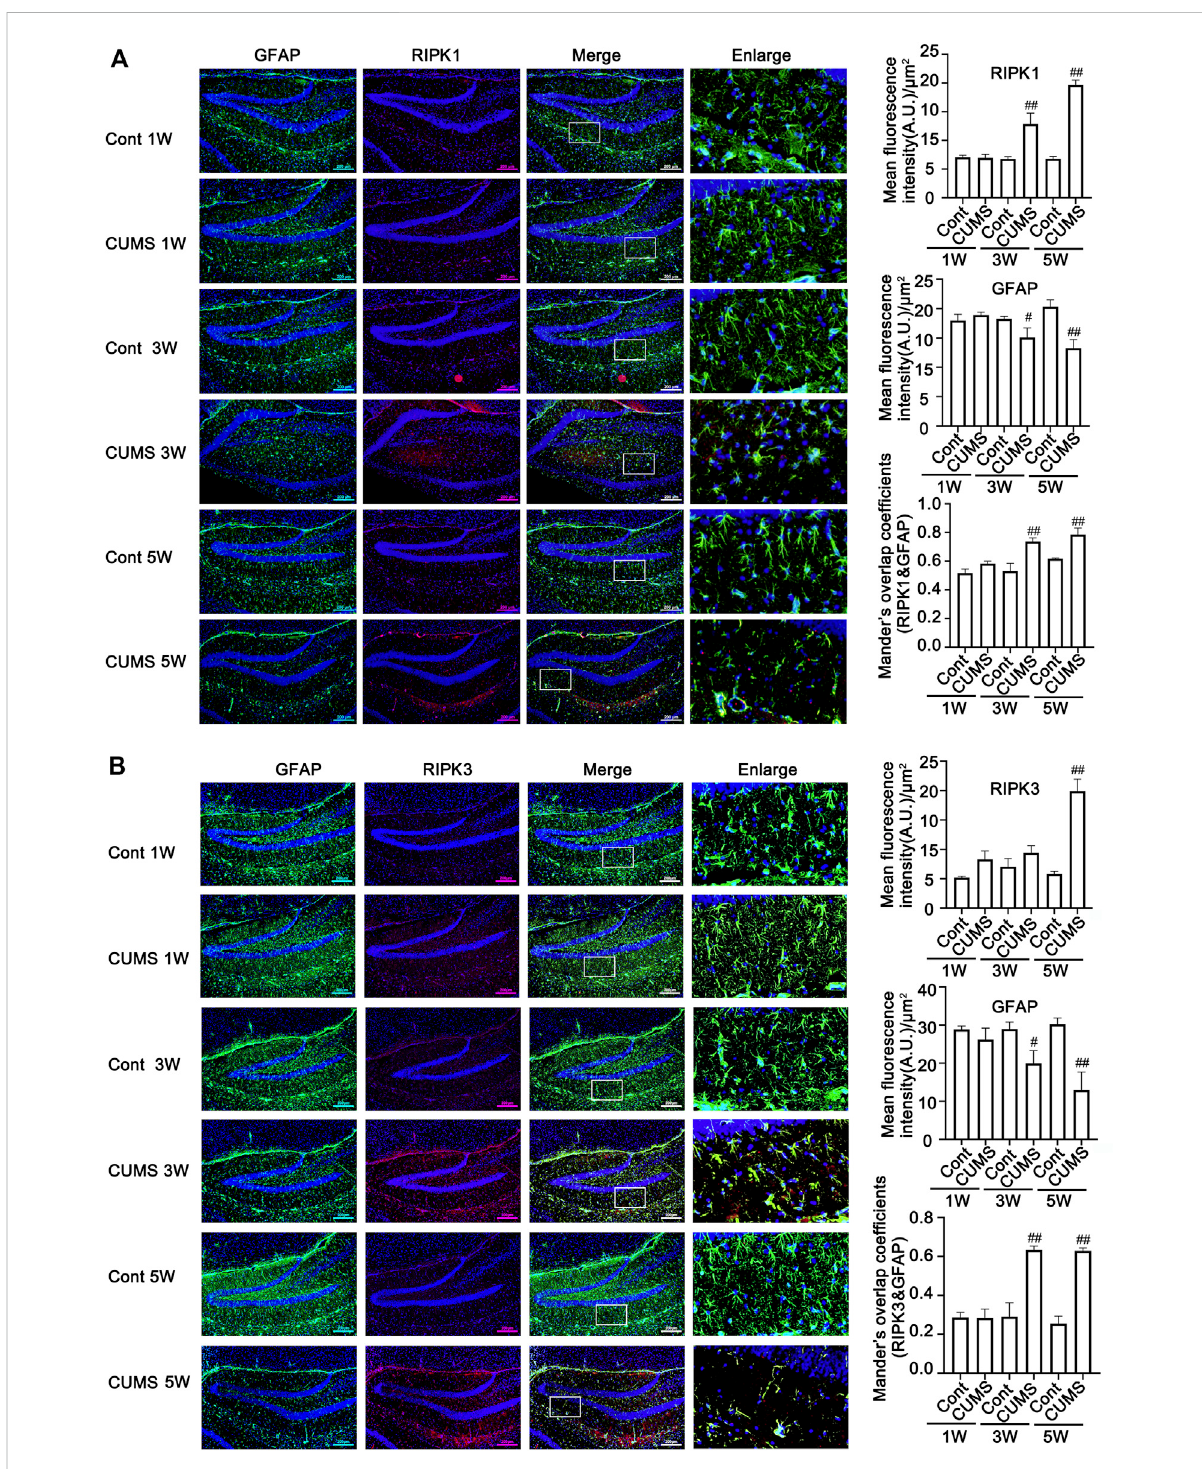
The expression of necroptotic kinases is increased in the hippocampal astrocytes of CUMS mice in a time-dependent manner. Representative images of double immuno fl uorescence staining showing the expression of RIPK1 (A) or RIPK3 (B) and GFAP in the hippocampus of Cont- or CUMS- treated mice at different time points. RIPK1 or RIPK3: red; GFAP: green; Hoechst: blue. Scale bars indicate 200 μ m. Mander ’ s overlap coef fi cient represents the true degree of colocalization, its values range from 0 to 1.0, and zero means that there are no overlapping pixels. ImageJ was used to calculate the colocalization coef fi cients. Statistical results were performed by one-way ANOVA with Tukey ’ s test and expressed as the mean ± SD , n = 3 per group, # p < 0.05, ## p < 0.01 vs. Cont.